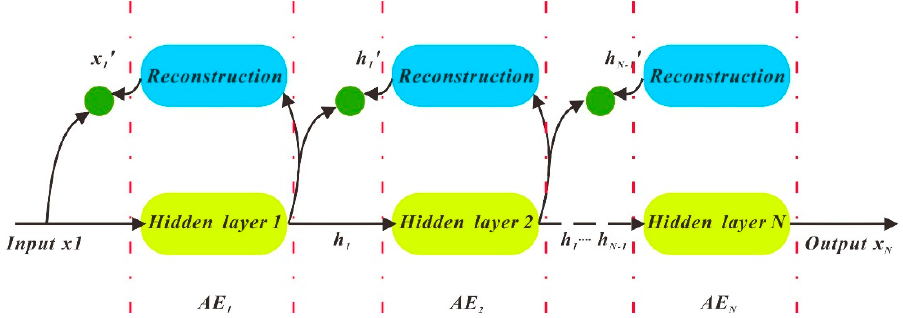
Figure 8. SAE structure diagram.